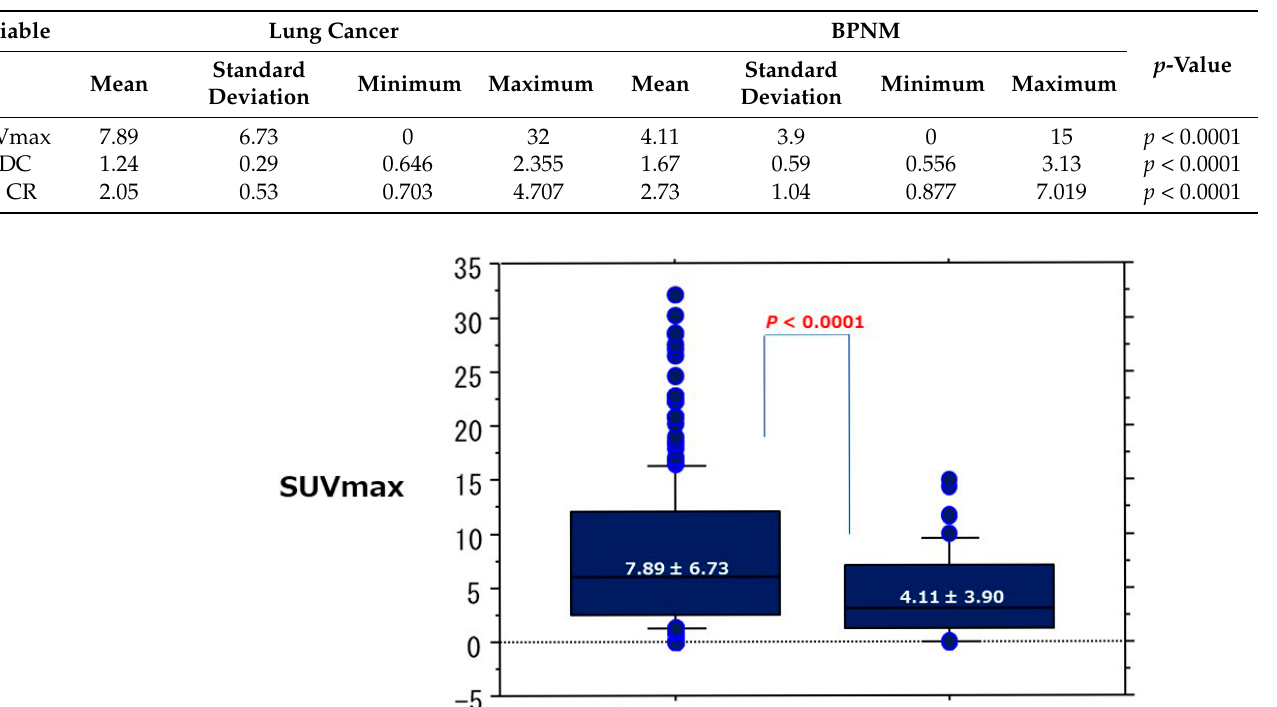
1.459 × 10 − 3 mm 2 /s, the sensitivity was 84.0%, the specificity 64.0%, and the accuracy 81.1%.